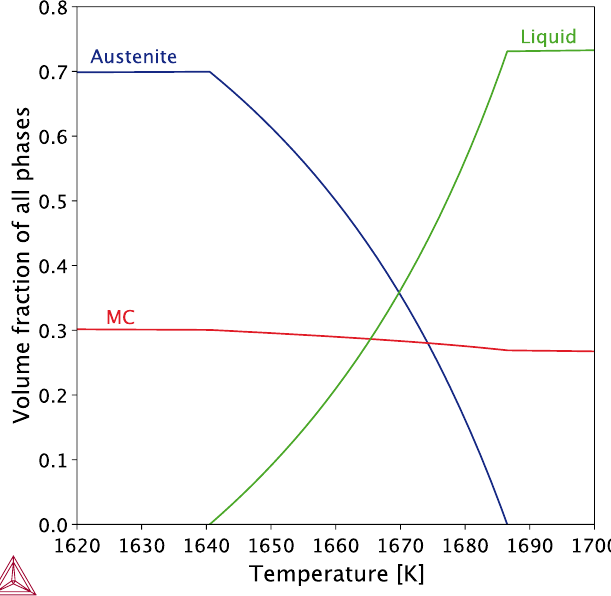
Figure 13. Micrographs showing reinforcement growth according to sintering temperature. Sintering Figure 13. Volume fraction of stable phases for matrix alloy composition of Table 3 as a function of temperature. M represents the metallic atoms, with Ti being the major element. at ( a ) 1273 K for 30 min, ( b ) 1573 K for 30 min, ( c ) 1673 K for 30 min, and ( d ) 1673 K for 300 min (reproduced with permission